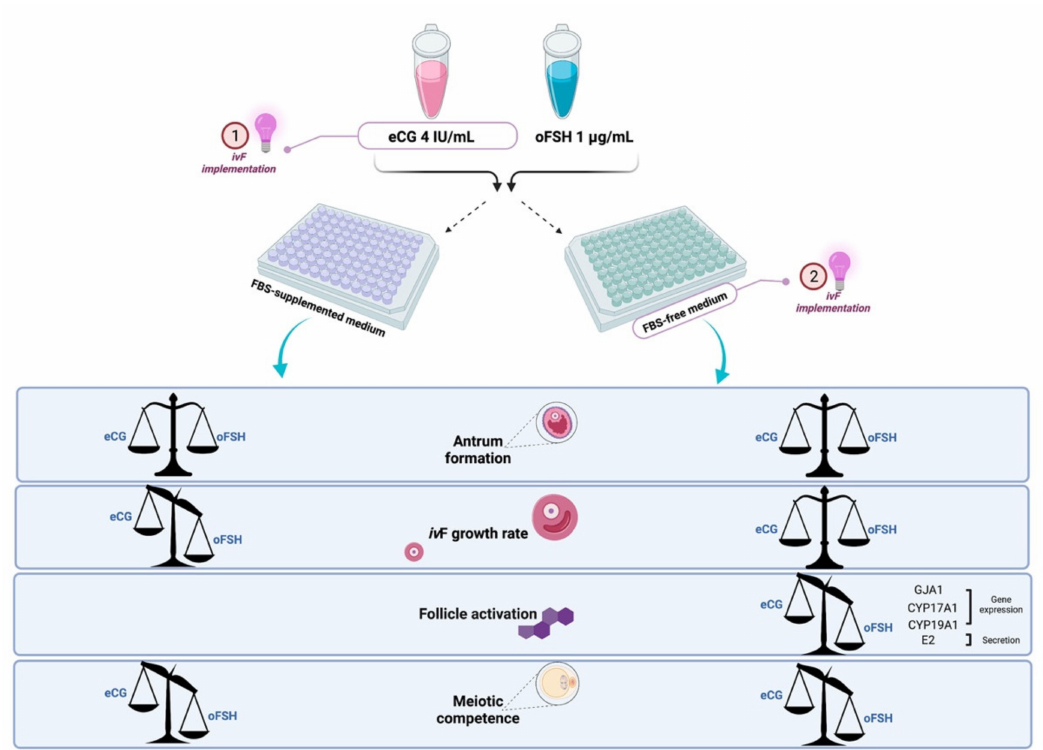
Figure 8. iv F outcome comparison between oFSH and eCG: iv F growth rate, antrum formation, follicle activation (steroido- genic transcriptional program activation and E2 secretion), and meiotic competence acquisition. Figure created with BioRender. Available online: https://biorender.com/ (accessed on 15 November